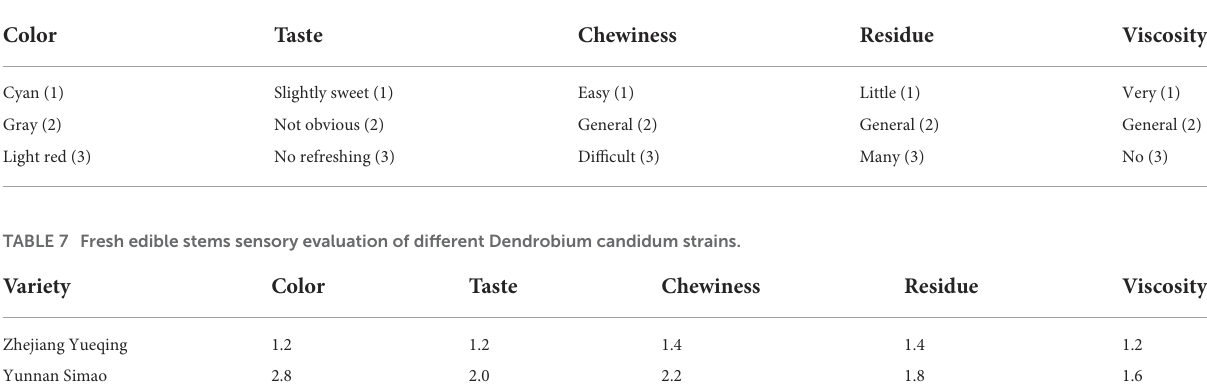
TABLE 6 Quantitative evaluation criteria for fresh sensory of Dendrobium candidum.